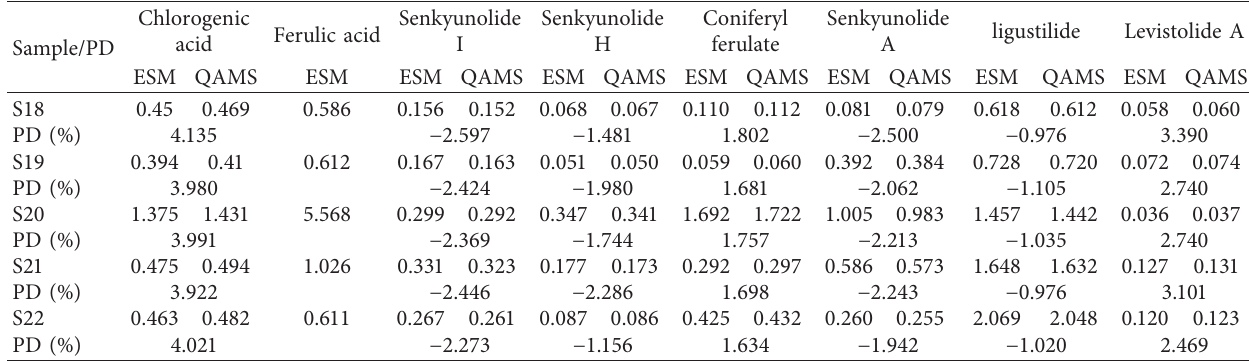
correction factor”. Table S1: effect of three different chro- matographic columns on RCF of 7 components. Table S2: effect of different column temperatures on RCF of each component. Table S3: effect of different flow rates on RCF of each component. Figure S1: HPLC chromatogram of mixed standard solution (a) and Angelica test solution (b). Note: 1, chlorogenic acid; 2, ferulic acid; 3, senkyunolide I; 4, sen- kyunolide H; 5, coniferyl ferulate; 6, senkyunolide A; 7, ligustilide; 8, levistolide A; Figures C and D are the cali- bration diagrams of Figures A and B, respectively. . (